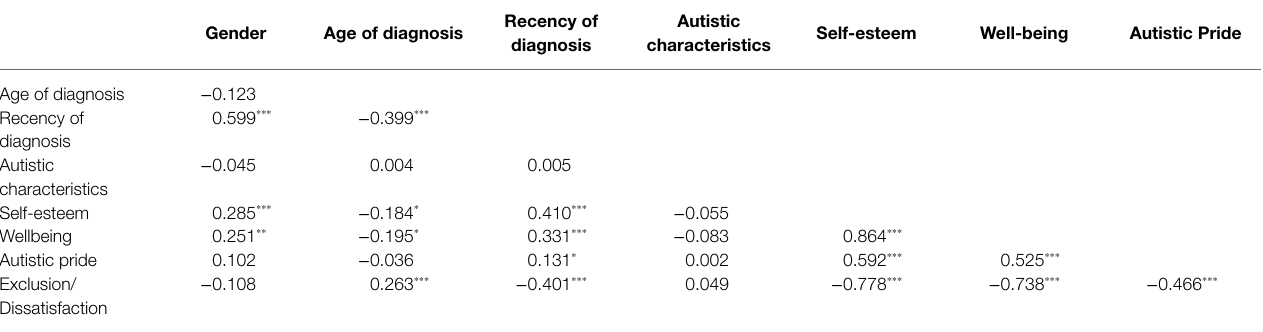
TABLE 3 | Pearson’s correlations between the variables included in the study. Gender Age of